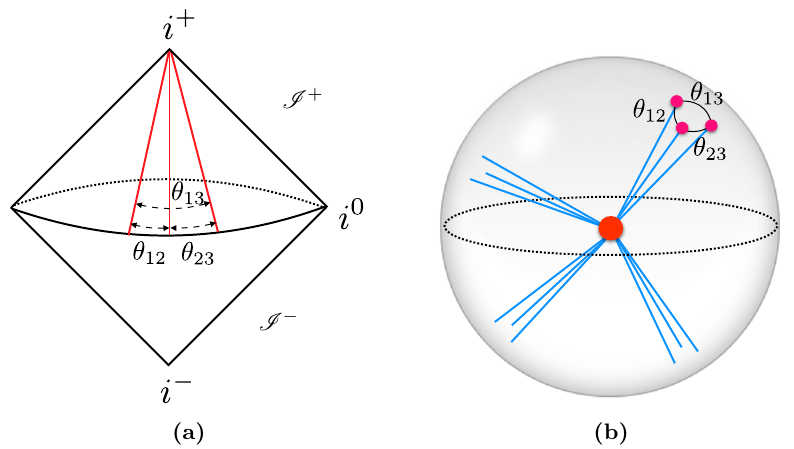
Figure 1. (a) Penrose diagram for the EEEC showing the three energy (cid:13)ow operators. One dimension of the S 2 has necessarily been suppressed. (b) The EEEC as measured on a jet in a four jet event. The pink dots denote energy (cid:13)ow measurement